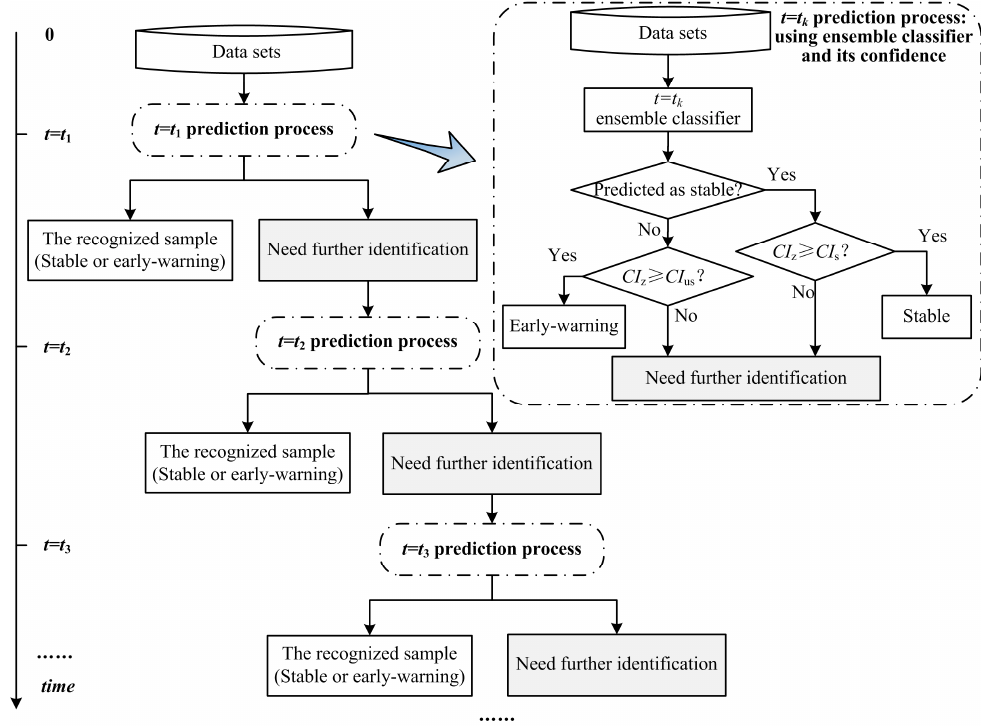
Figure 11. Hierarchical scheme for transient stability prediction.